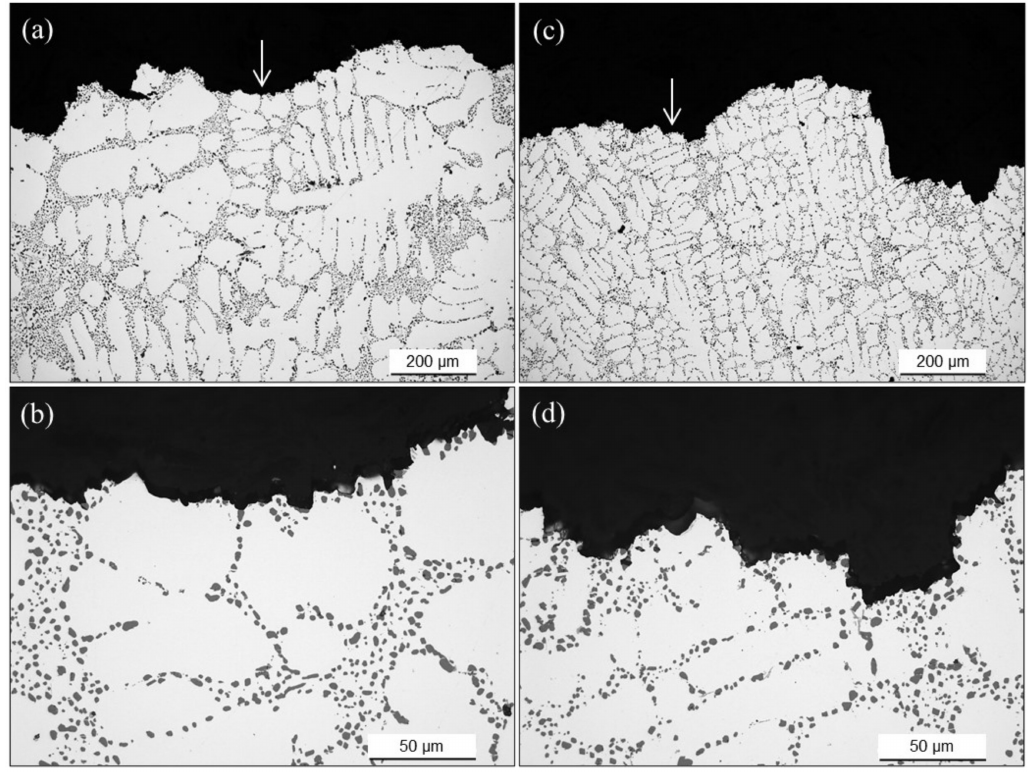
Figure 12. Cross sections of the tensile specimens obtained from casting SK-1: ( a , b ) area A1 with SDAS of 37.8 µ m, ( c , d ) area A4 with SDAS of 27.2 µ m. Images ( b , d ) correspond to high magnification views of the zones indicated with white arrows in images ( a , c ),